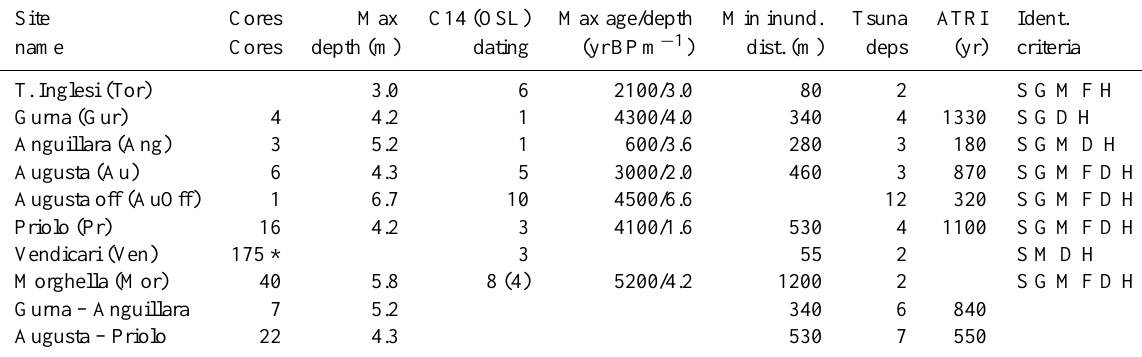
Table 2. Summary of the main collected data. Please note that at Torre degli Inglesi and Vendicari sites the working approach did not involve coring, but the study of an archaeological exposure and boulders, respectively. The number with * in the Vendicari line indicates the number of studied boulders. Average Tsunami Recurrence Interval is shown with the acronym ATRI (penultimate column). The tsunami identification criteria are shown in the last column with the following keys: S – stratigraphic, G – grain size, M – macrofauna, F – foraminifera, D – distance from the coastline, H – if the tsunami deposit age is compatible with an historical event. Site C14